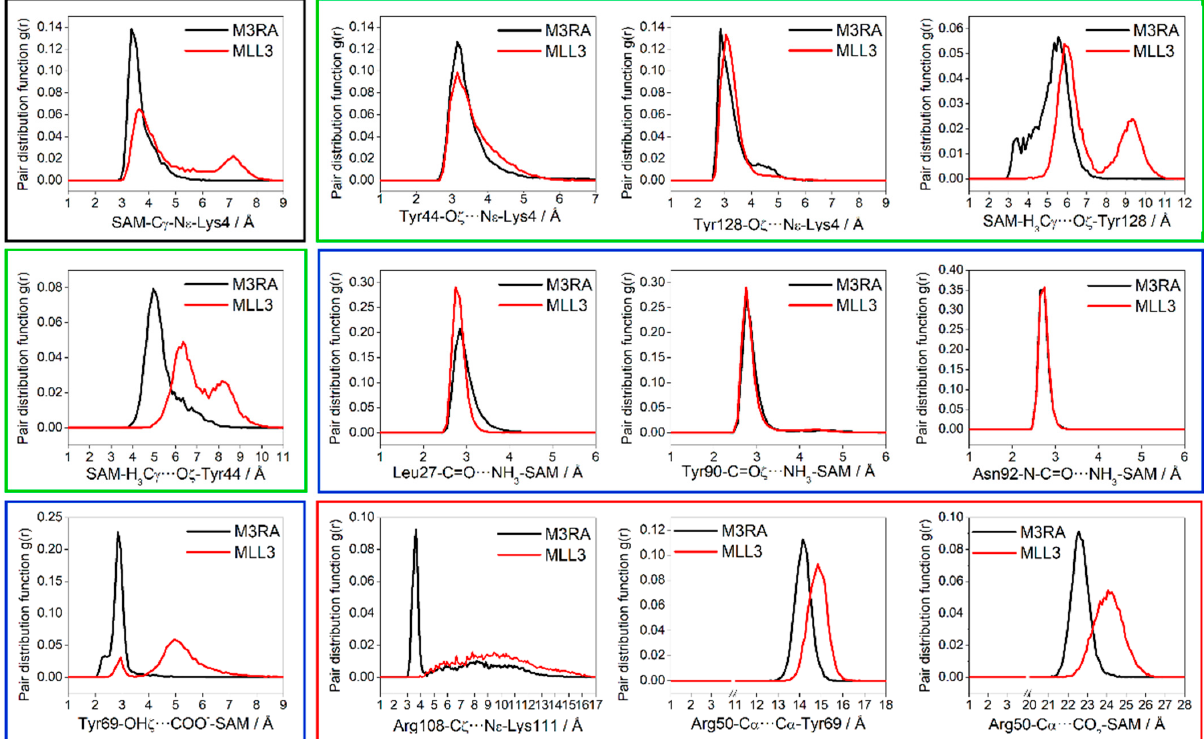
Figure 9. Plots of the pair distribution functions for selected distances associated to the activation mechanism sampled along 50 ns of molecular dynamic simulations of M3RA and MLL3. In the green box are the interactions involving Tyr44 and Tyr128, in the blue box are the interaction of SAM with the residues from its binding site, and in the red box are selected distances that pinpoint structural changes caused by the dimer binding to MLL3.